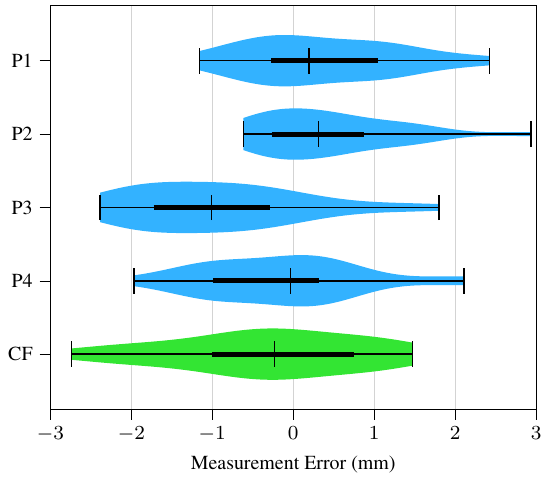
Figure 6. Distributions of measurement differences from the expert assessor’s over participants for the non-experts using Cliniface for manual measurement (blue), and Cliniface using non-rigid registration to derive measurements